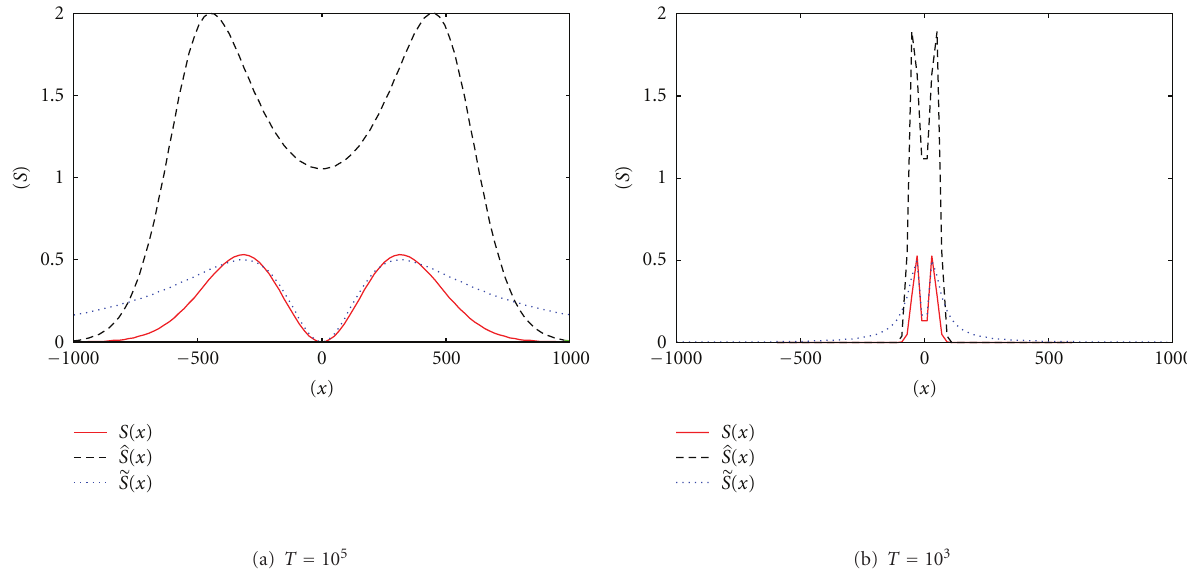
Figure 1: The plots of the entropy functions S , S and (cid:11) S at (a) high and (b) low temperature ( n = 1, c = 2, q = 1 . 5, α k = − 2).